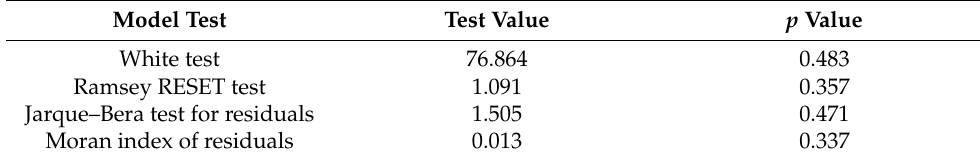
Table 14. Test of ESF model II (ln(Comp V) as thedependent variable). Model